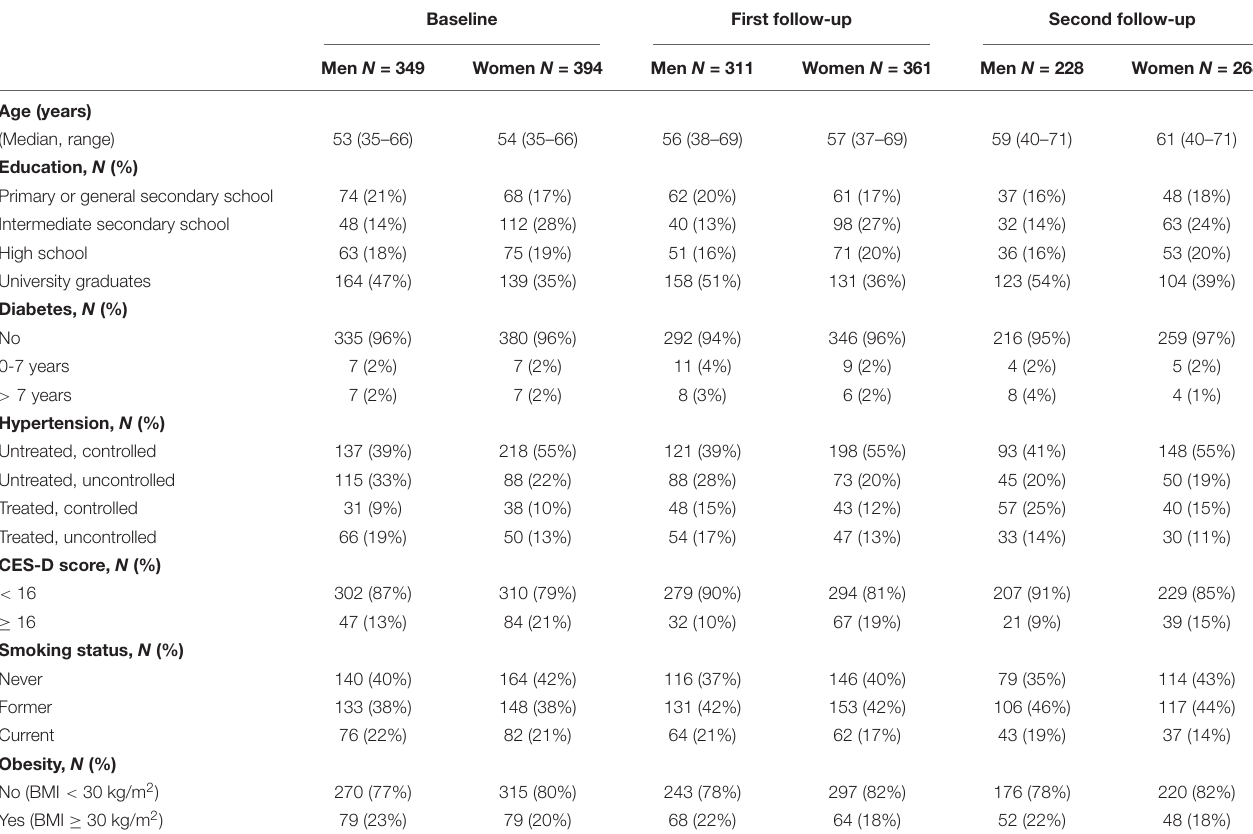
TABLE 1 | Study population at baseline and two